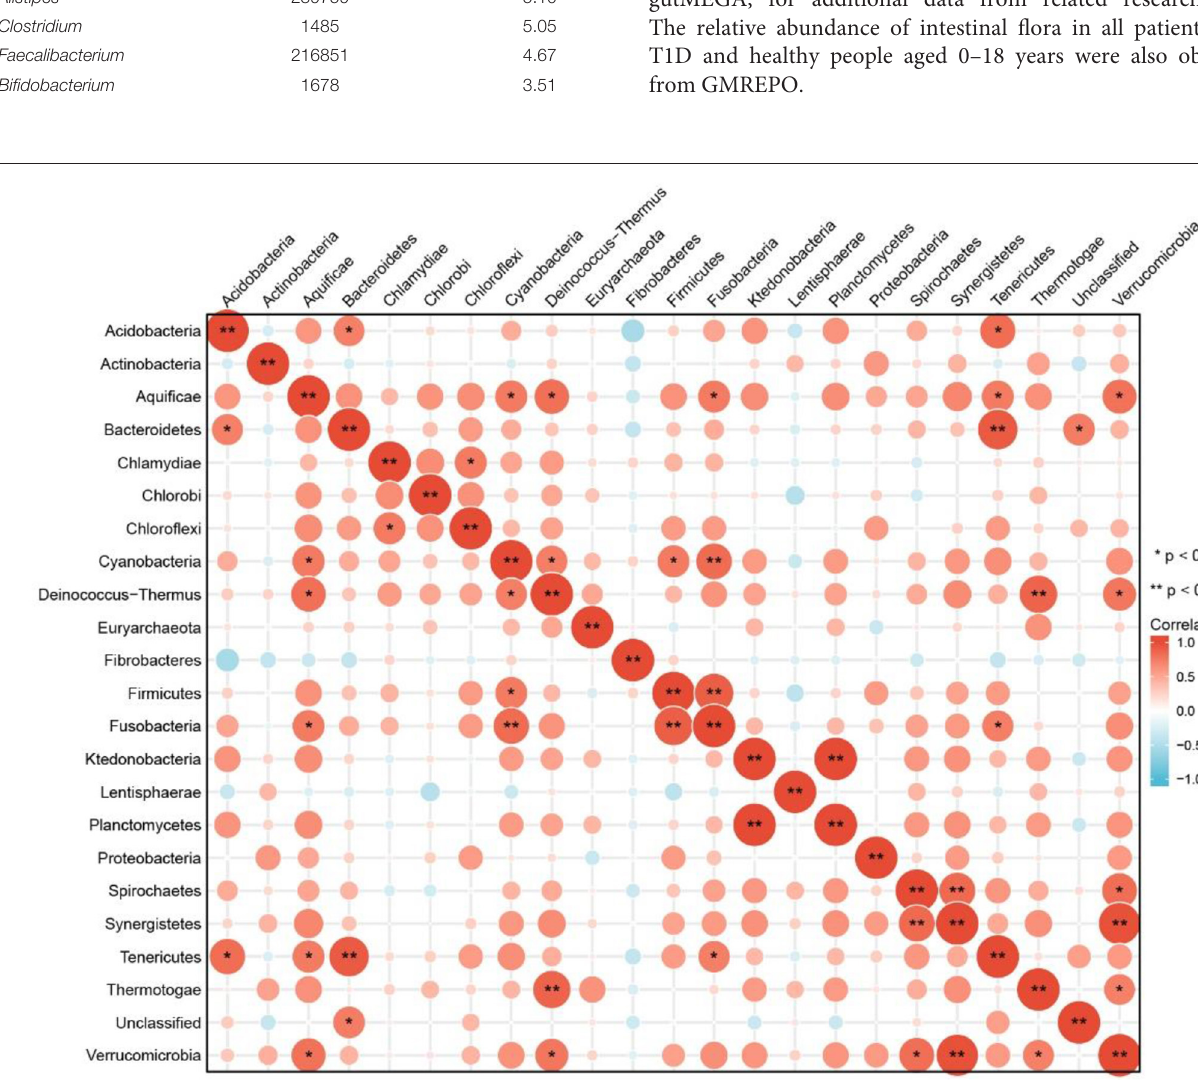
Frontiers in Pediatrics |